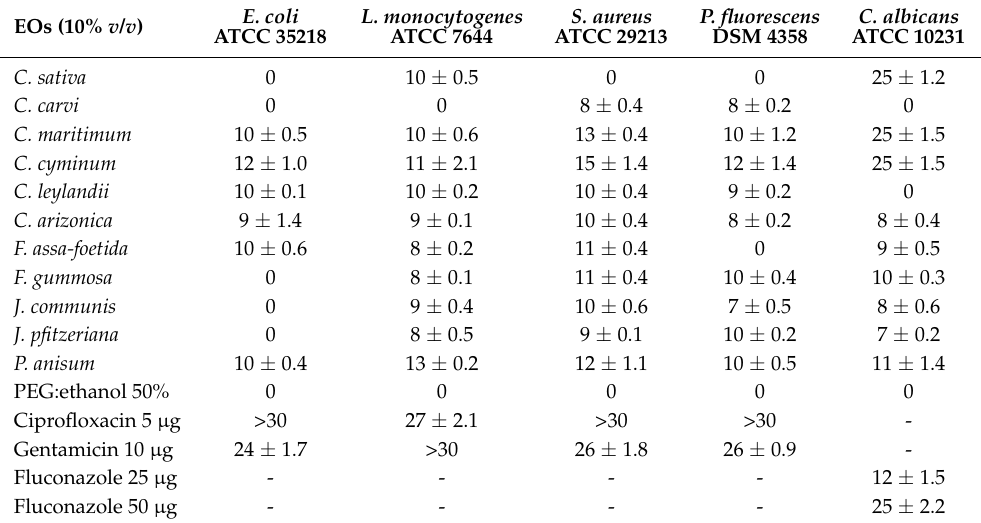
Table 1. Antimicrobial activity of the examined eleven essential oils (EOs) (10% v / v ) against food- borne pathogens and spoilage microorganisms determined by AWDM. Antibiotics (gentamicin and ciprofloxacin), or antifungal (fluconazole) as well as PEG:Ethanol 50% were used as controls. Data rep- resent the growth inhibition diameter (GID; mm; mean ± sd) of independent experiments performed in duplicate. EOs (10% v / v